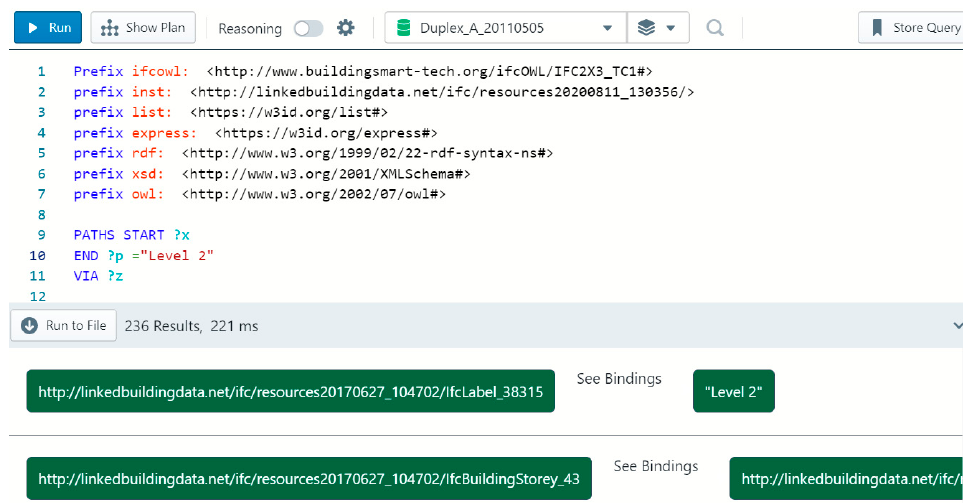
Figure 6. The result of Stardog path query of the keyword “Level 2”.